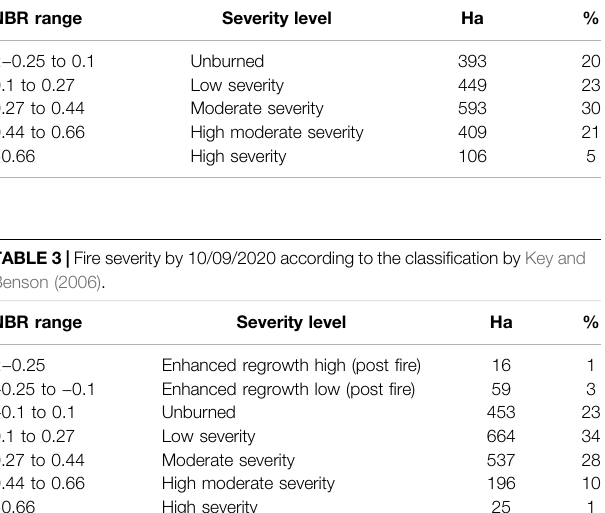
TABLE 2 | Fire severity by 23/05/2020 according to the classi fi cation by Key and Benson (2006). NBR range Ha % < − 0.25 to 0.1